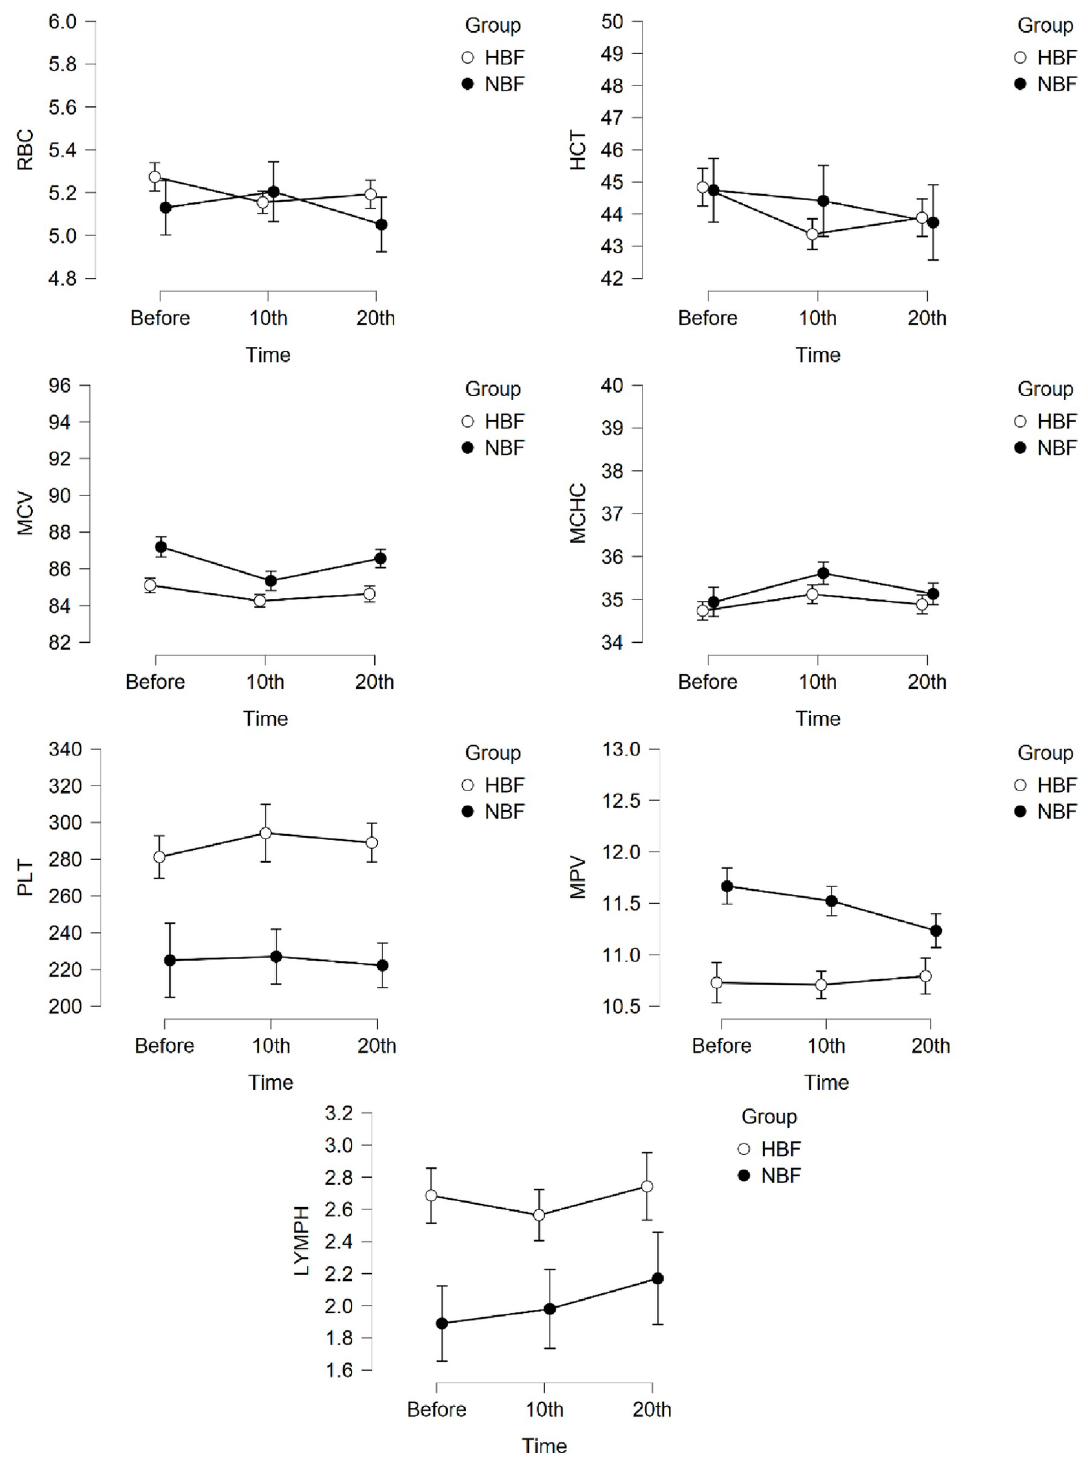
Fig 2. Changes in mean values of hematological parameters for which statistical significance was demonstrated.